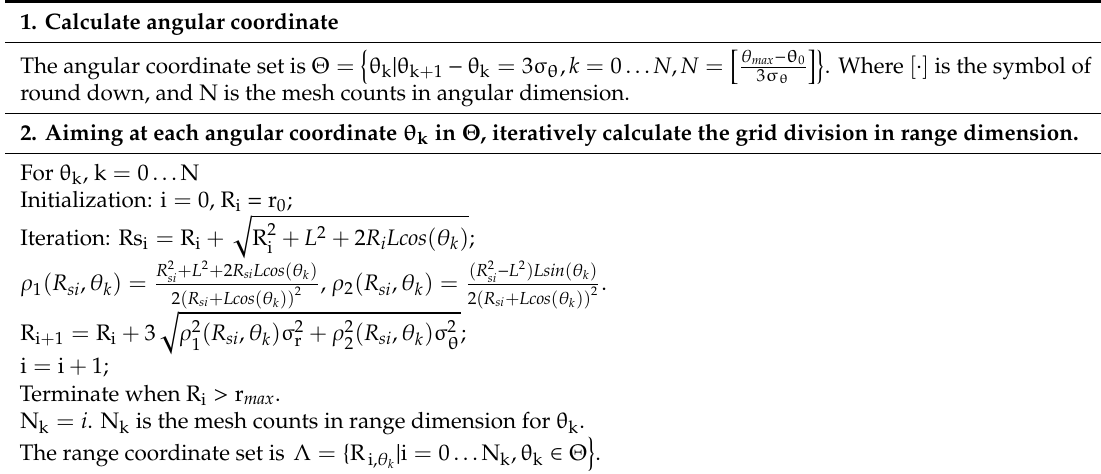
Table 1. The polar mesh grid calculation steps.